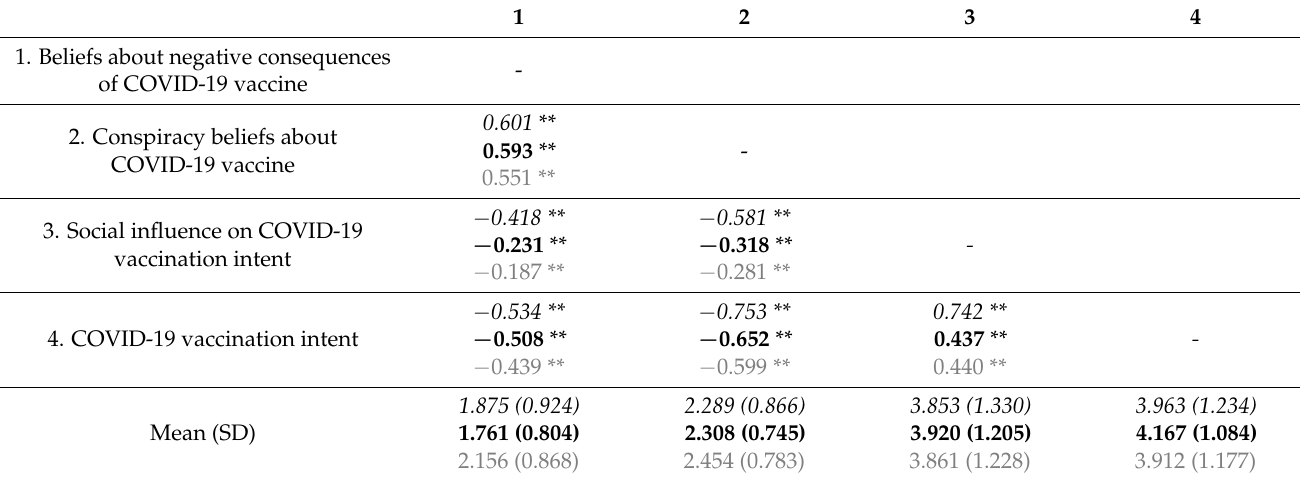
Table 2. Correlation among study variables in Chile, Mexico, and